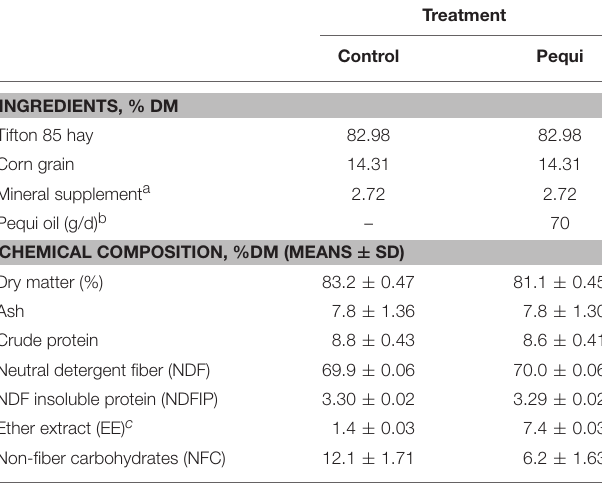
TABLE 2 | Chemical composition and ingredients of the diet.